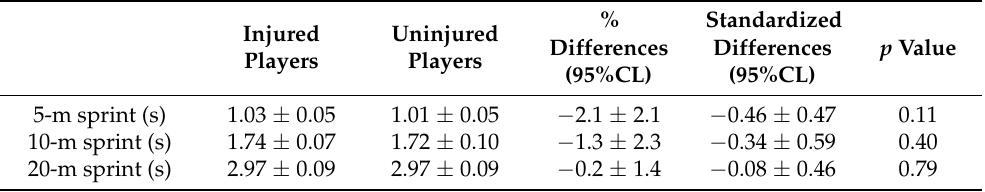
Table 4. Comparison of sprinting performance between the injured players (i.e., players with a history of a previous injury within the last two competitive seasons) and all uninjured limbs in the uninjured